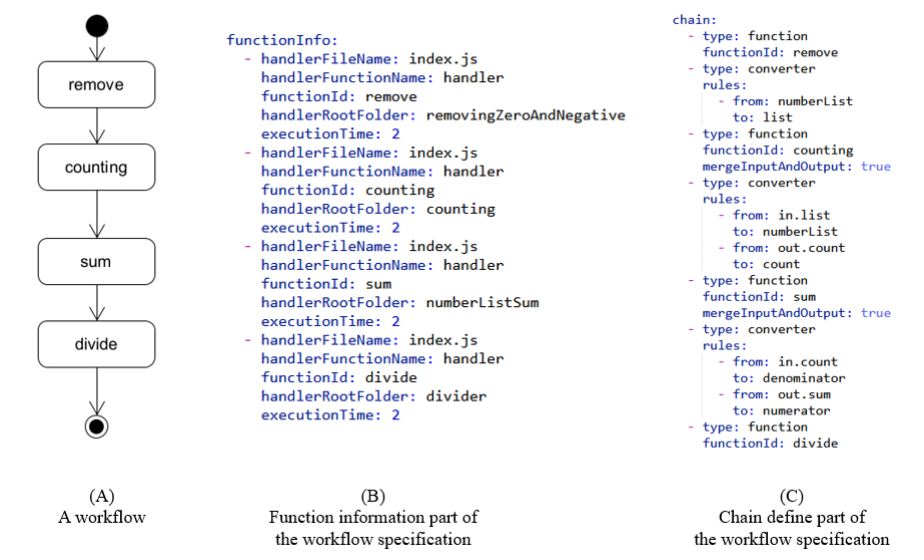
Figure 8. Example to show the workflow specification written by YAML. This workflow specification contains message transformation